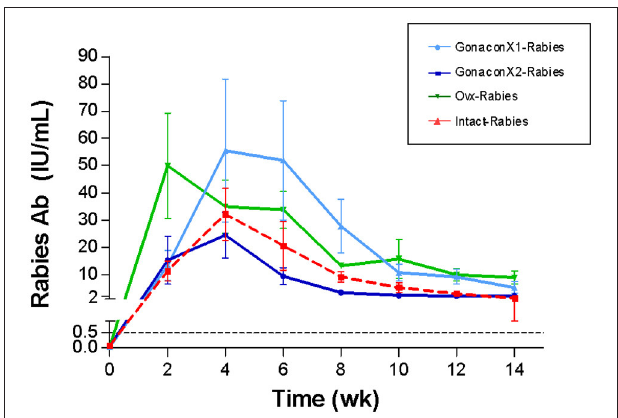
FIGURE 7 | Serum rabies antibodies of cats in the research groups. Mean ± SEM rabies antibodies concentrations are presented for each group: GonaconX1-Rabies: cats vaccinated with both Gonacon and rabies ( n = 5); GonaconX2-Rabies: cats vaccinated twice with Gonacon (3 weeks apart) and with rabies ( n = 4); OVx-Rabies: cats ovariohysterectomized and vaccinated with rabies ( n = 4); Intact-Rabies: cats vaccinated against rabies and remained intact ( n = 3). Blood samples were collected every 2 weeks for a total of 14 weeks. There were no significant differences in the rabies antibodies among the groups ( p = 0.3169), or group X time interaction ( p = 0.7220); however, the time was a significant factor (Repeated measure ANOVA, p < 0.0001). Dotted lines indicate protective titer ( > 0.5